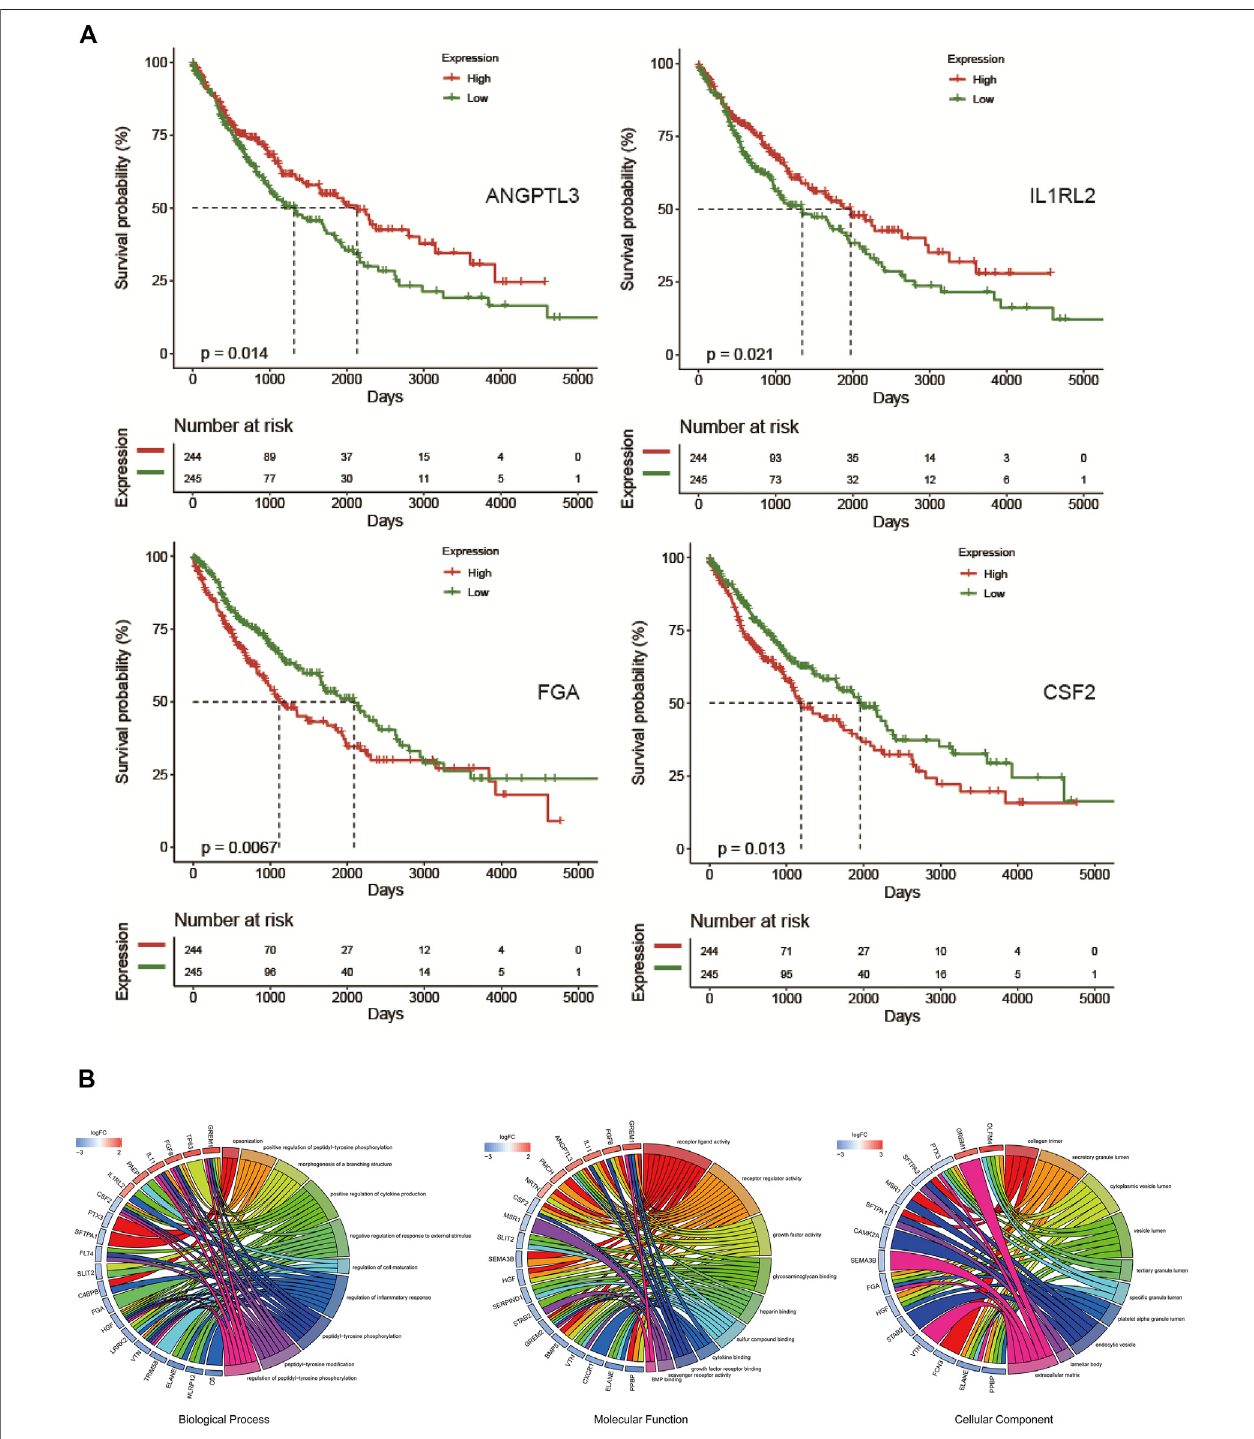
FIGURE3| Overallsurvival-related genesandenrichmentanalysis. (A) OverallsurvivalcurveofANGPTL3,IL1RL2, FGA,and CSF2. (B) GOenrichmentanalysisof 46 overall survival-associated genes.